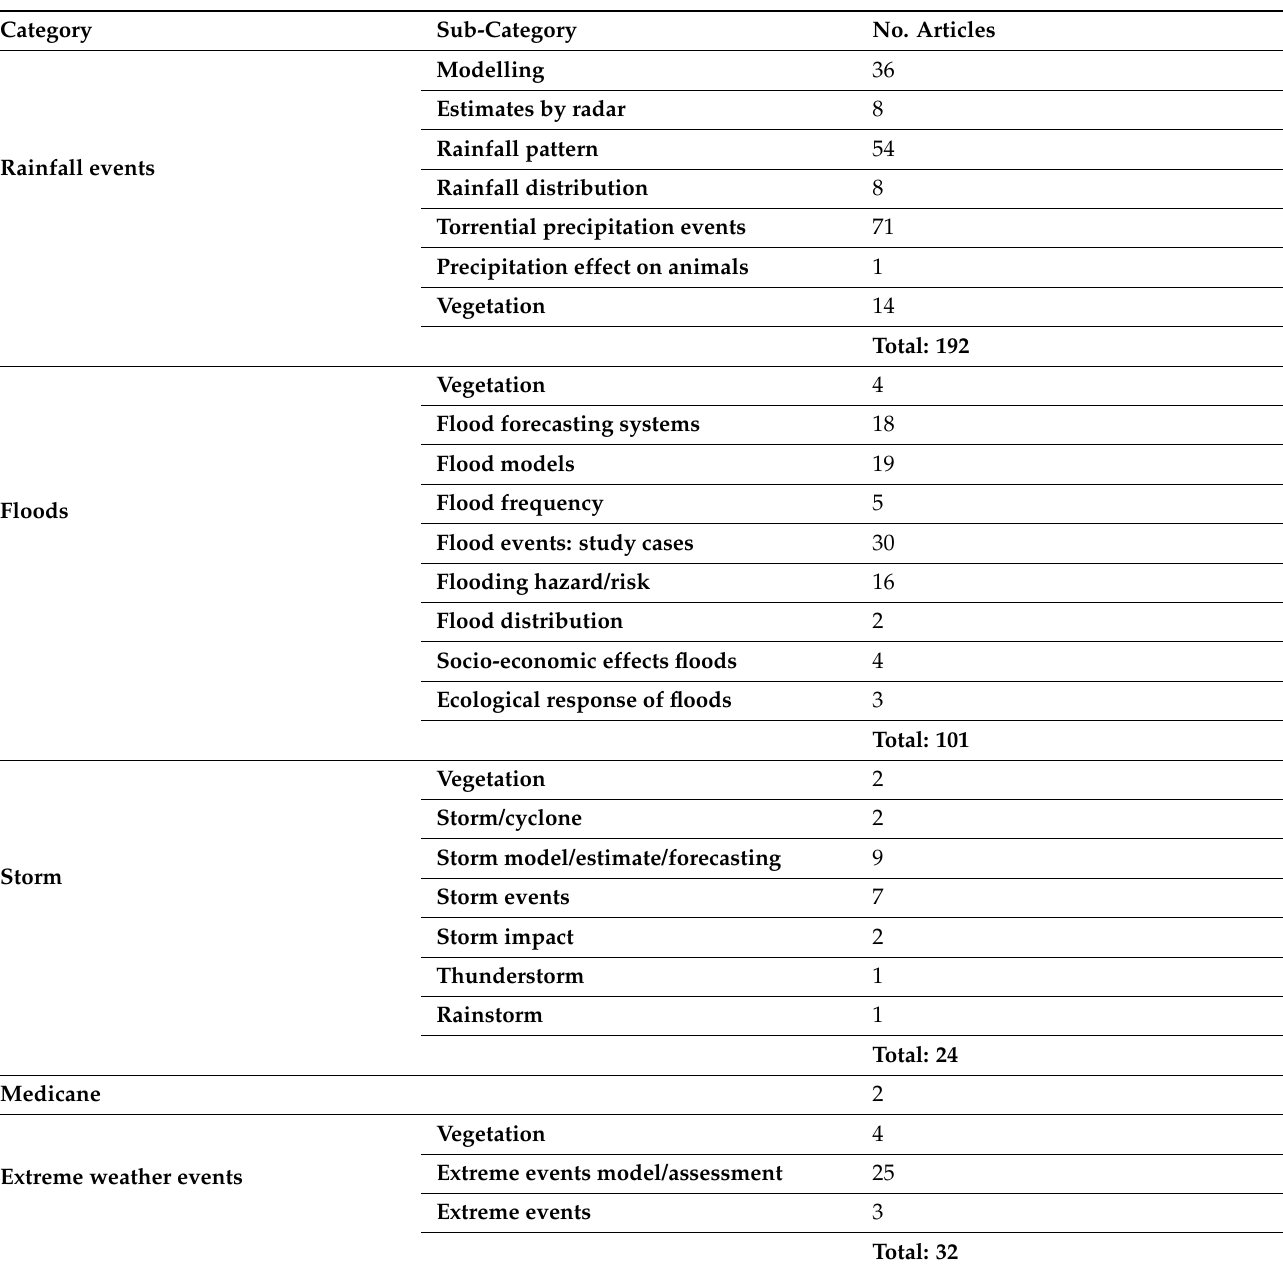
Table 1. Total articles relating to the effects of extreme rainfall events in the Mediterranean Basin. The articles were classified into category and sub-category, and the number of articles in each category was